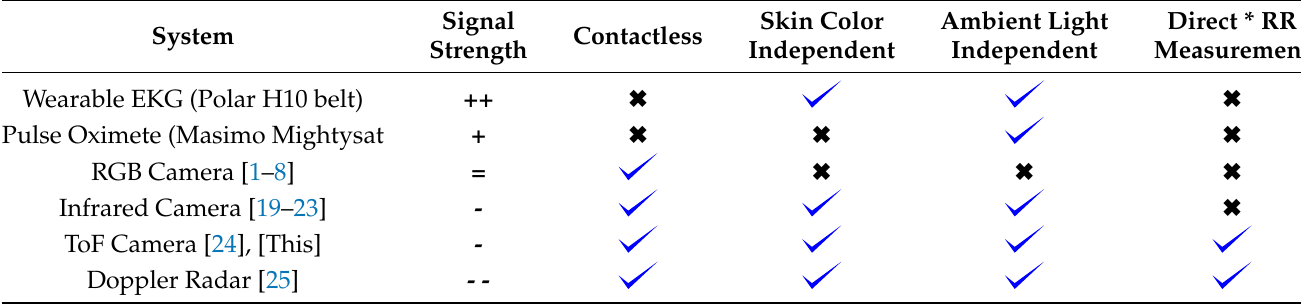
Table 1. Comparison of HR measuring